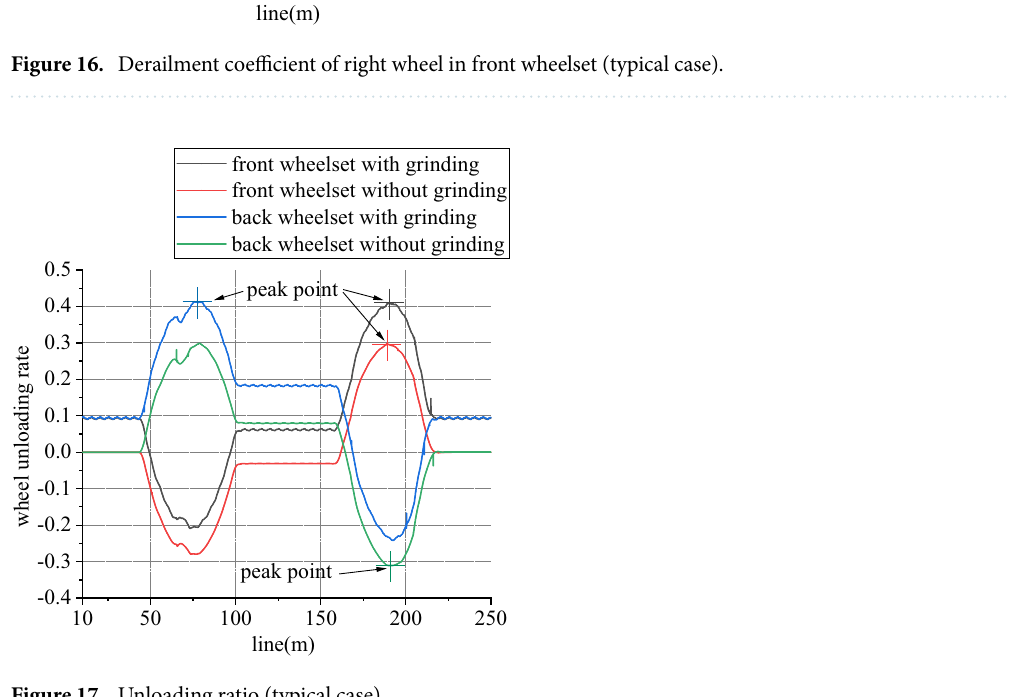
Figure 17. Unloading ratio (typical